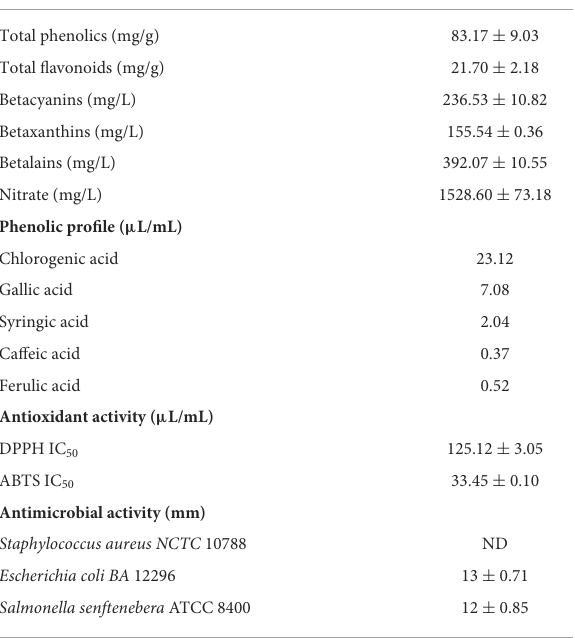
TABLE 3 Characteristics of beetroot peel water